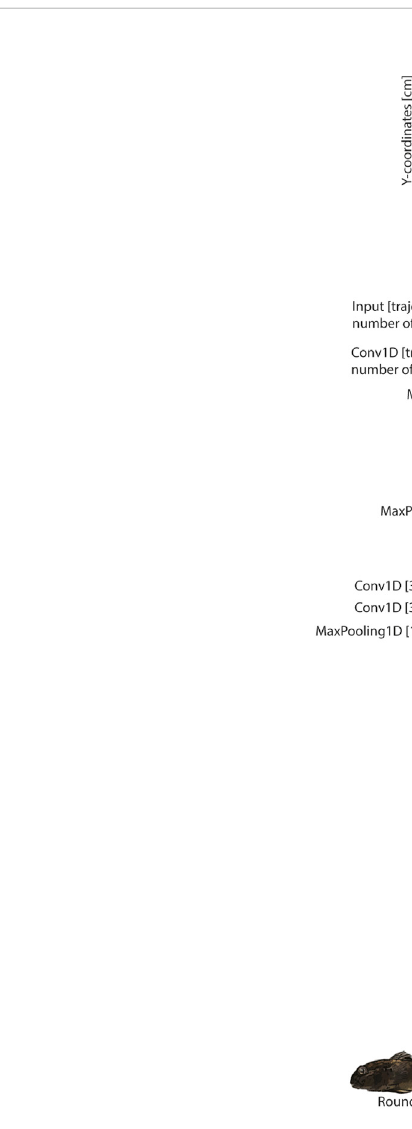
FIGURE 2 A convolutional neural network was designed and trained on the passage swimming trajectories to predict the fi sh species. The trajectories of standardized length (125 point coordinates) were rescaled and fed to the input layer, which was followed by three convolutional blocks. These convolutional blocks were followed by a fully connected block and three model output nodes, which provide the classi fi cation signal for the three fi sh